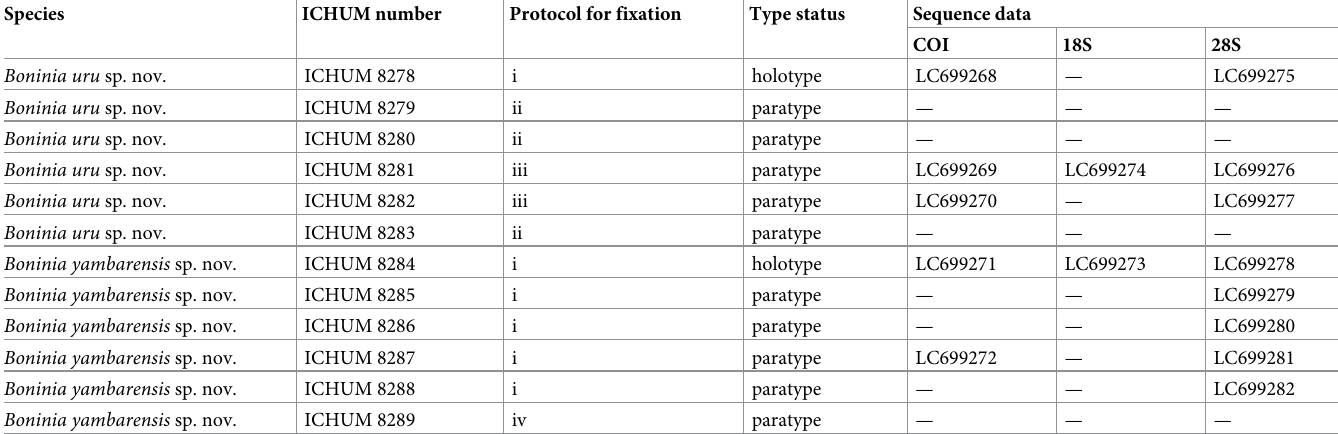
Table 1. List of protocols for fixation and GenBank accession numbers of the sequences of